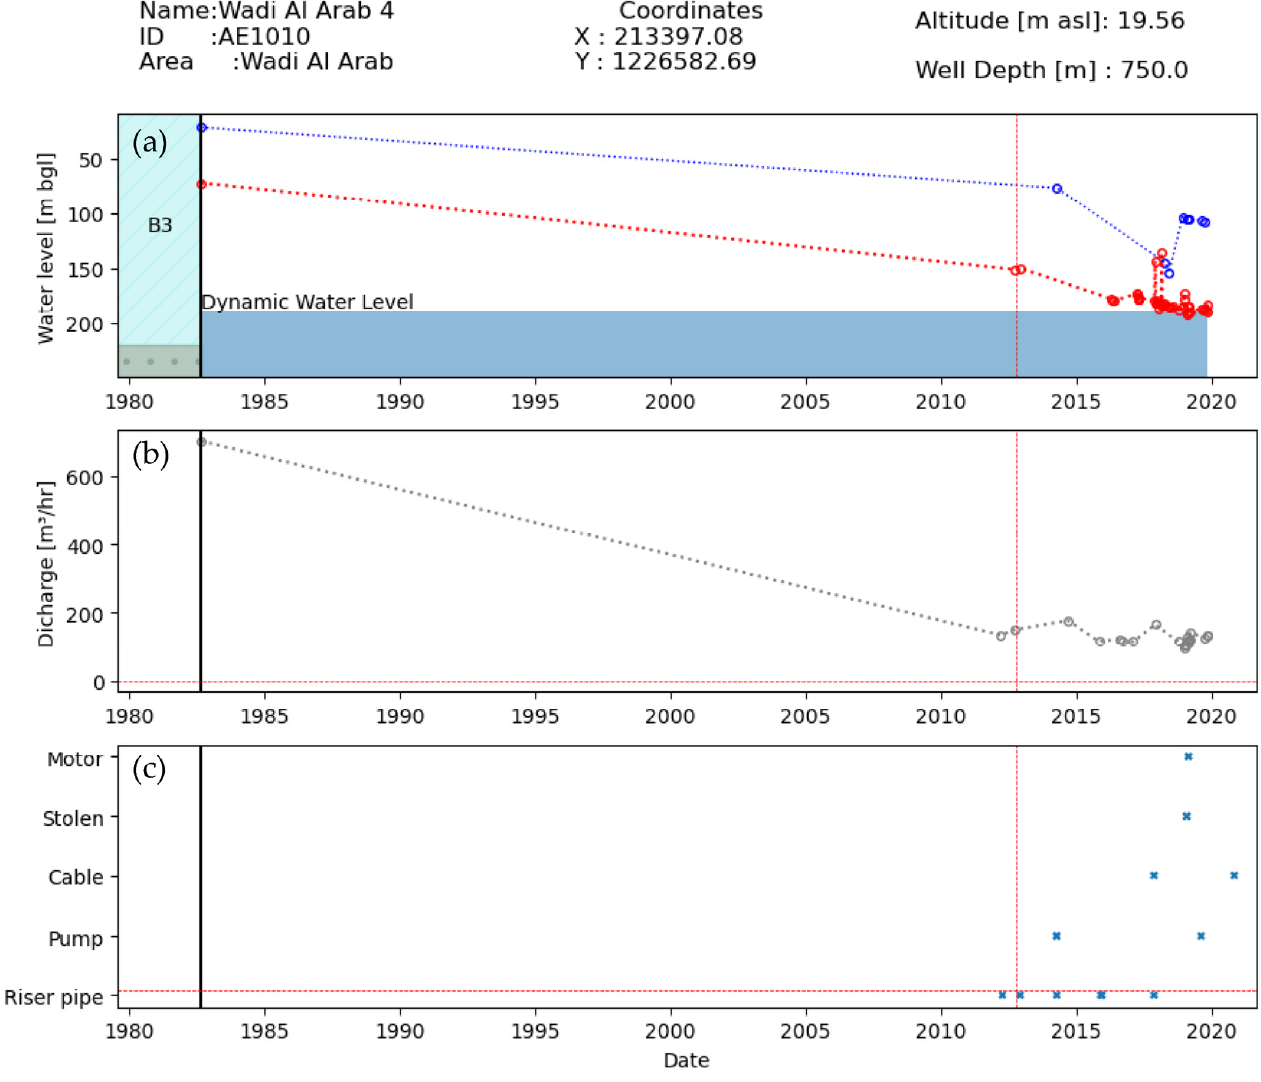
Figure 6. Wadi Al Arab 4 (AE1010) diary graph as part of the OBT. ( a ) The change in groundwater level (blue dots represent the SWL and red dots represent the DWL) since the drilling of the well, the lithological units of the well, ( b ) the changes in the discharge (m 3 /h) over the same period, and ( c ) the reasons behind interrupting the well’s operation over time. The red cursor is to link the three figures ( a – c ) visually.